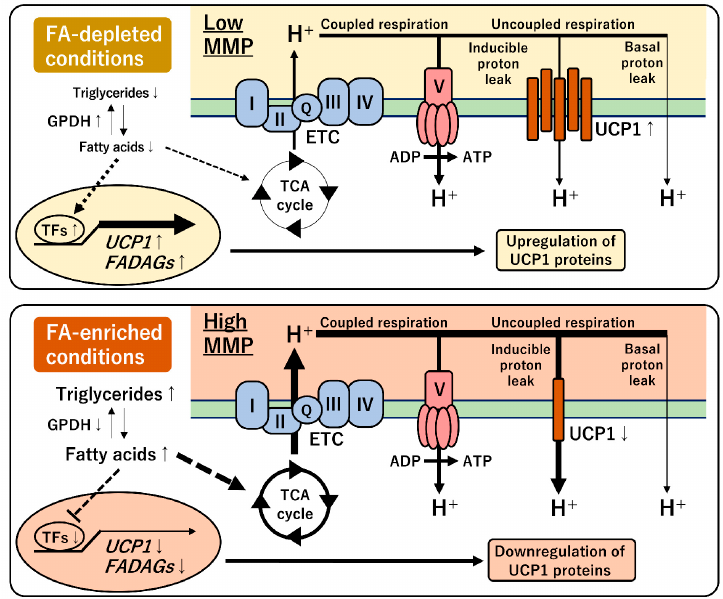
Figure 8. Schematic model of the regulation of UCP1 expression under different FA conditions. The FA-depleted conditions induce UCP1 expression under low MMP ( top panel ). Conversely, the FA- enriched conditions activate MMP, however, UCP1 expression is repressed ( bottom panel ). This feedback regulation between UCP1 expression and mitochondrial-energy status may be required to coordinate the inducible proton-leak activity in human brown adipocytes.